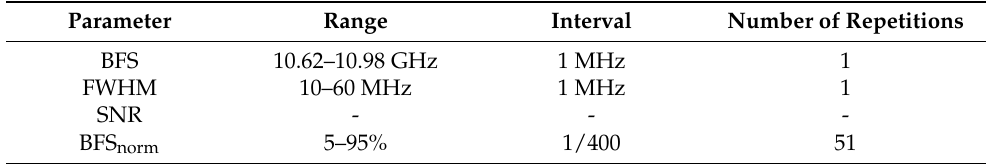
Table 2. Details of the clear BGSs used to obtain PCs. The starting frequency, the ending frequency, and the frequency scanning step of BGS were 10.6 GHz, 11.00 GHz and 2 MHz, respectively.